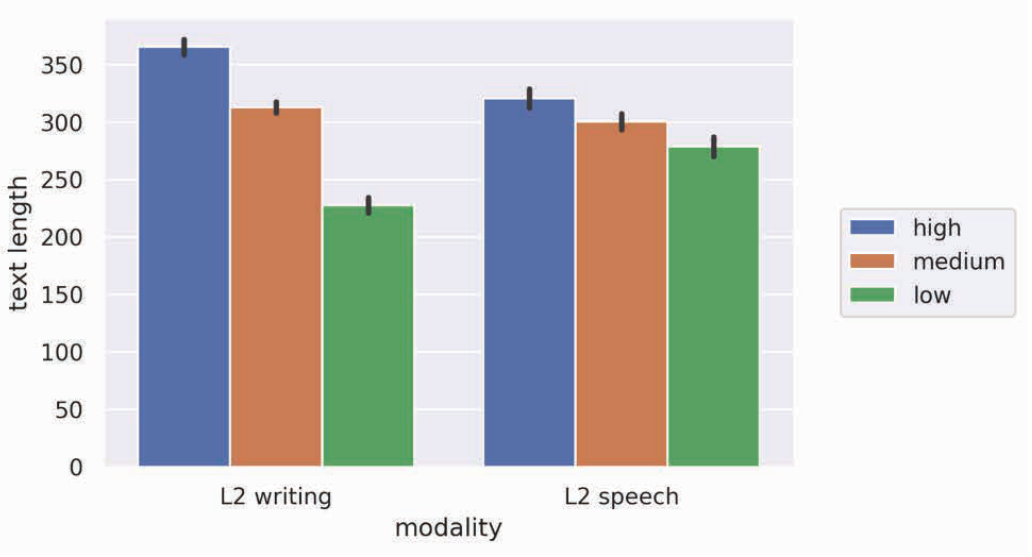
Fi gure 3: Text lengths across proficiency levels in L2 writing and